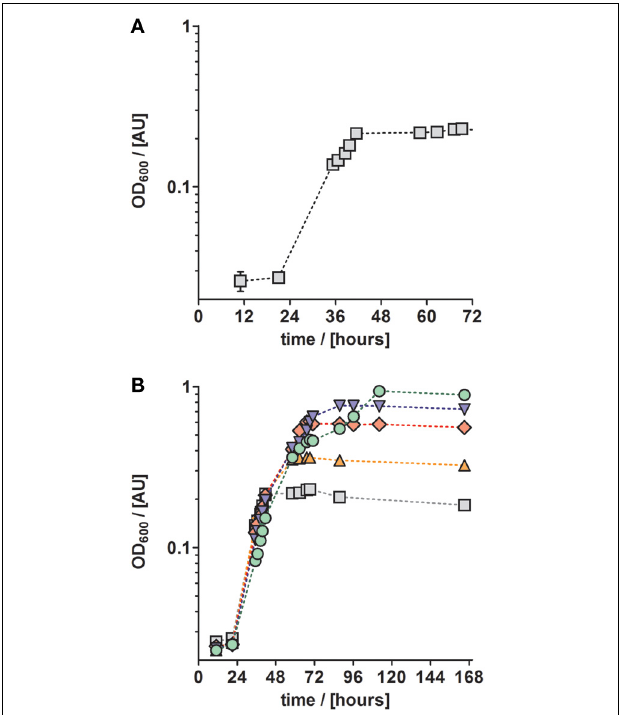
FIGURE 3 | Anaerobic growth of P. denitrificans with respect to different trace element compositions and concentrations. The influence of a set of trace elements on growth was studied by growing P. denitrificans with six different trace element compositions, as listed in Table 2 (series 3). (A) Solution TE-3 (purple up triangles); TE-3-Co, solution TE-3 with additional cobalt (orange circles); TE-3-Zn, solution TE-3 with additional zinc (blue hexagons), TE-3-B, solution TE-3 with additional borate (green down triangles); TE-3-Ni, solution TE-3 with additional nickel (red diamonds); TE-4, solution TE-3 containing all additional elements (gray squares). (B) The same trace element solutions as described in (A) were supplied at ten times higher concentrations. Growth curves depicted in all panels represent at least two duplicates; error bars indicate standard deviation and may be smaller than the